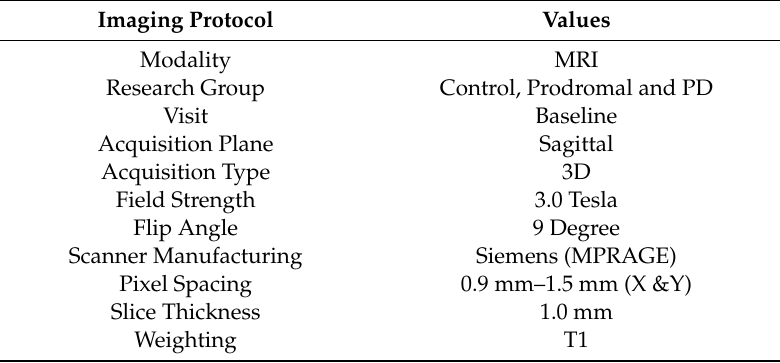
Table 1. Parameters for choosing MRI Scans from the PPMI Study.